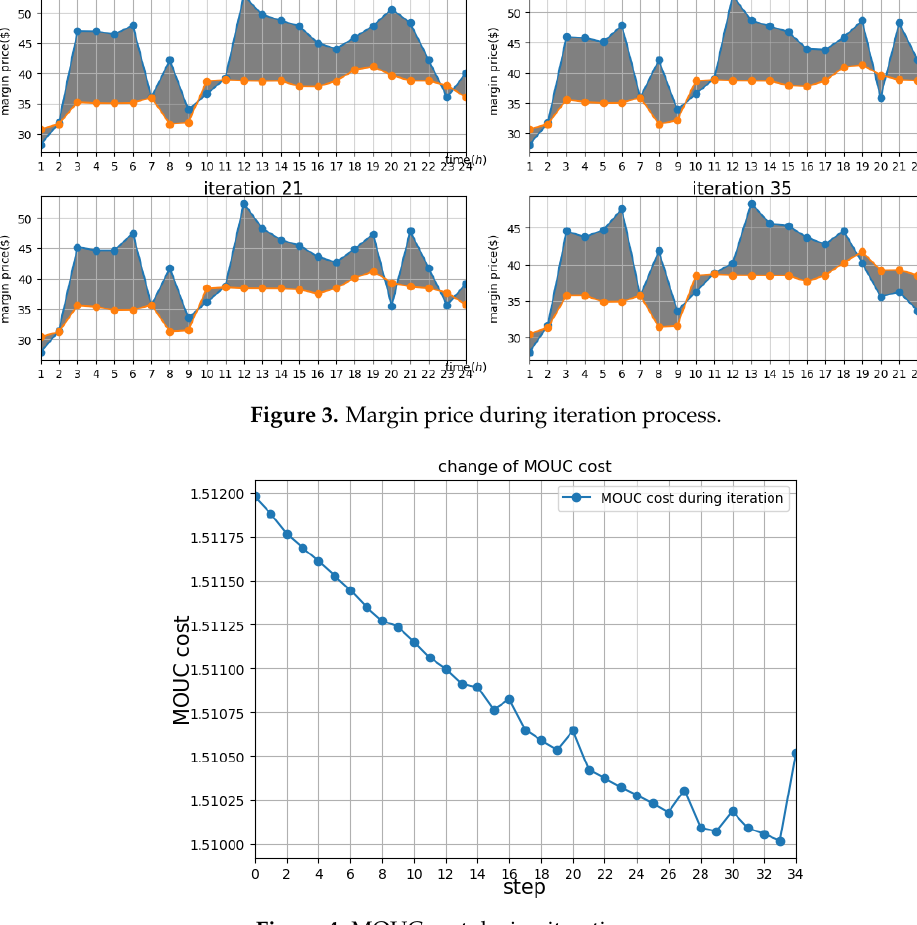
Figure 4. MOUC cost during iteration